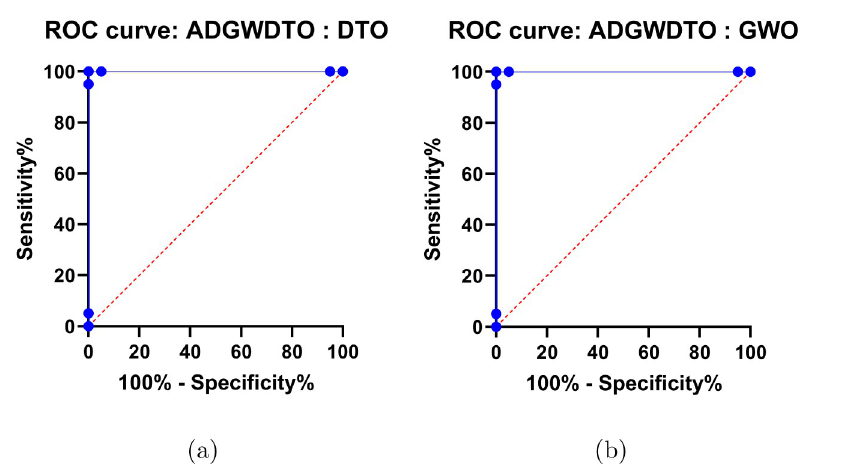
Fig 5. The ADGWDTO algorithm versus DTO and GWO algorithms ROC curves, (a) ADGWDTO versus DTO and (b) ADGWDTO versus GWO.